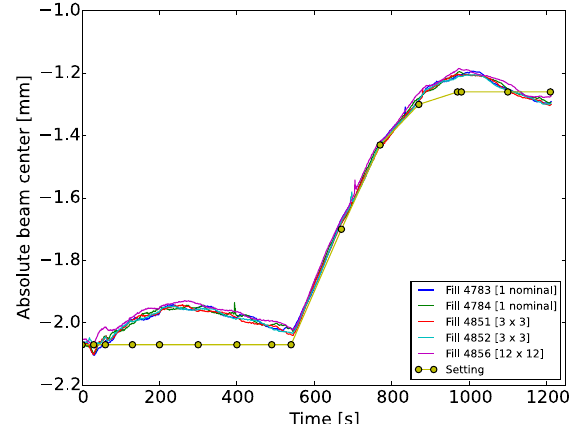
FIG. 21. The absolute measured beam orbit at the collimator together with the setting for the TCTPH.4L5.B1 during the combined ramp and squeeze.